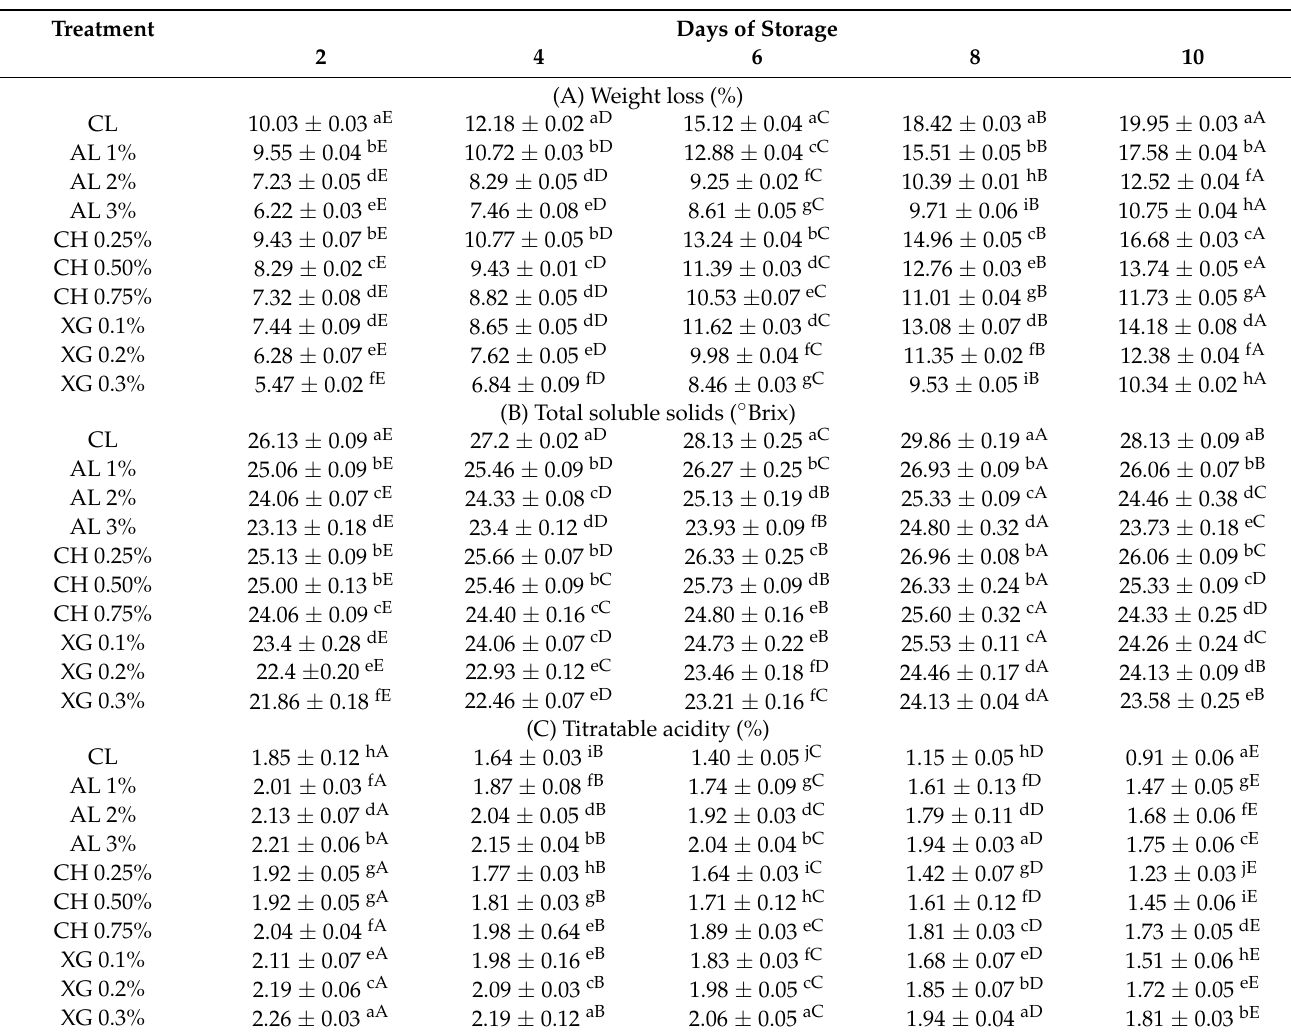
Table 1. Effects of polysaccharide-based coatings and storage on weight loss (%), total soluble solids ( ◦ Brix),